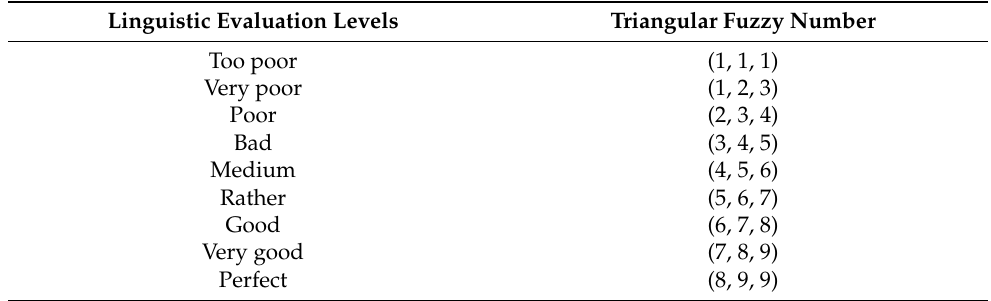
Table 4. Assessment of linguistic levels of the alternatives in the fuzzy TOPSIS